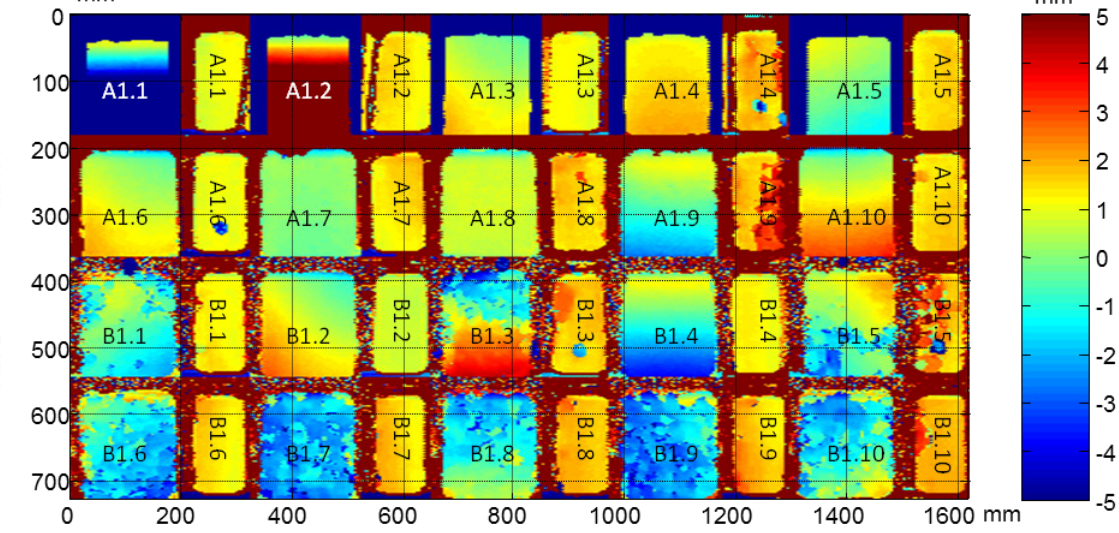
Figure 23. Dimensions of concrete specimens obtained from the ultrasonic inspections after the F-T